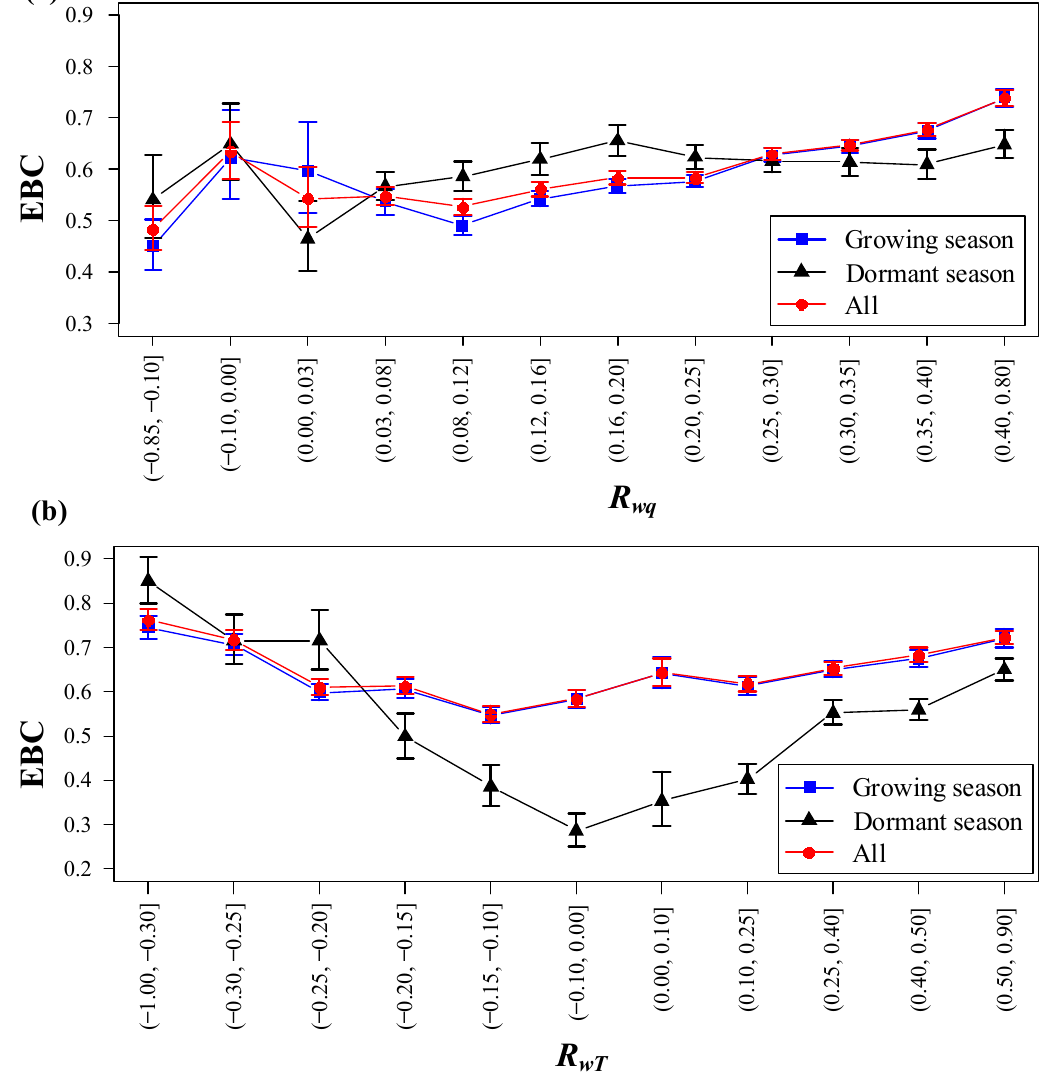
Figure 10. Average EBC for each bin of ( a ) water vapor density ( R wq ) and ( b ) water vapor density temperature ( R wT ). Dots indicate the slope of the relationship between available energy (Rn − G − S) and total heat flux (H + LE), and error bars represent the 95% confidence interval of the slopes from SMA.